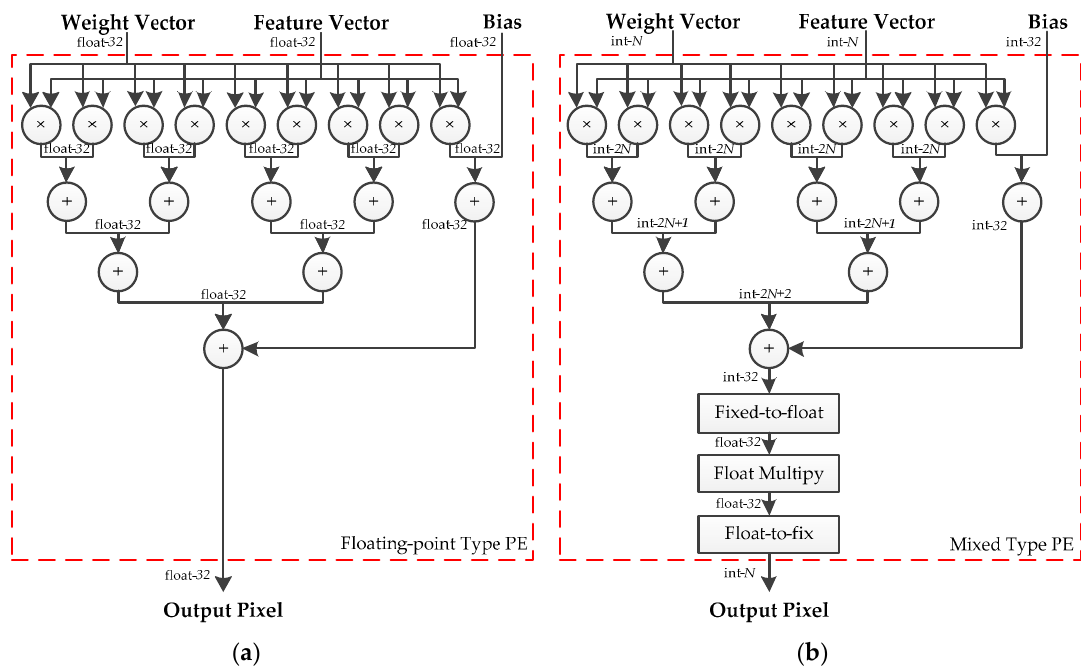
Figure 5. Fusing floating-point multiplication for the optimization to hardware design.